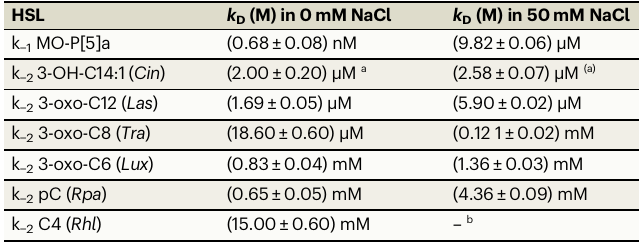
Table 1 | Binding af fi nities for host-guest interactions between the macrocycle P[5]a and HSLs, determined through dye displacement with the MO